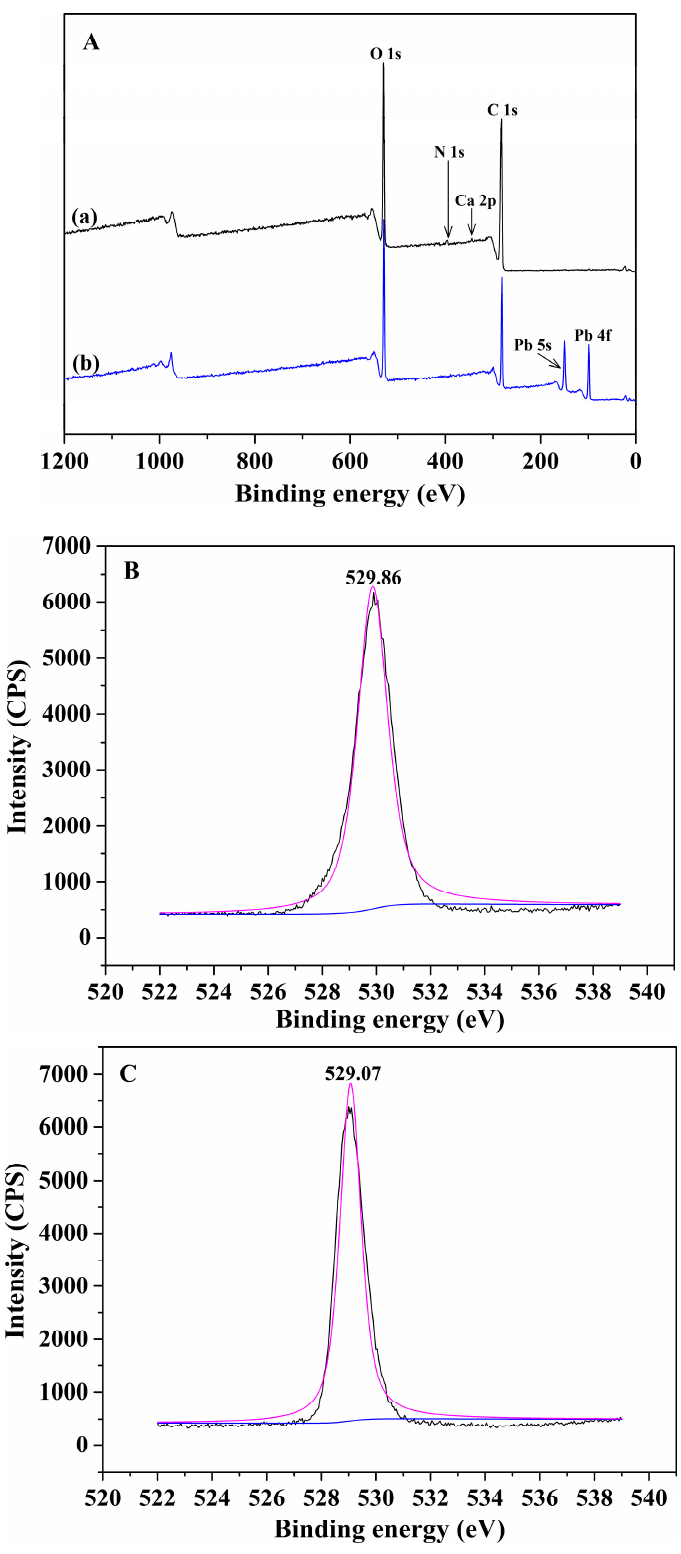
Figure 10. ( A ) XPS survey of ( a ) Alg-EDTA and ( b ) Alg-EDTA loaded Pb 2+ . O 1s spectra of Alg-EDTA ( B ) before and ( C ) after Pb 2+ adsorption.